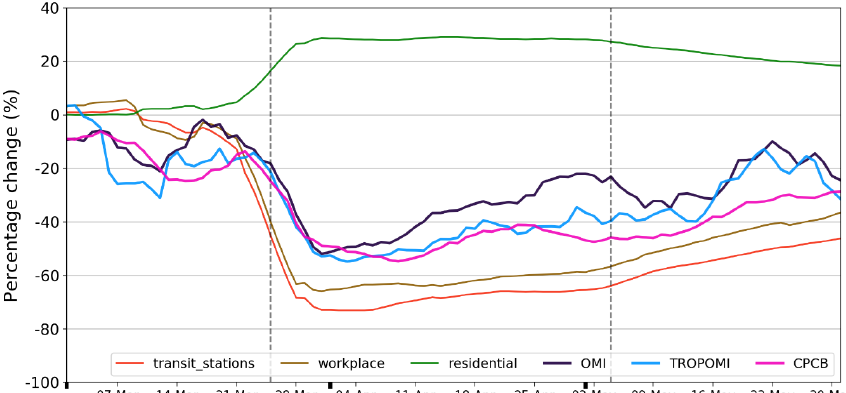
Figure 10. Temporal evolution of estimated change (7d rolling mean) of satellite-observed VCD trop NO 2 and surface-measured NO 2 for the period 1 March–31 May 2020 from the